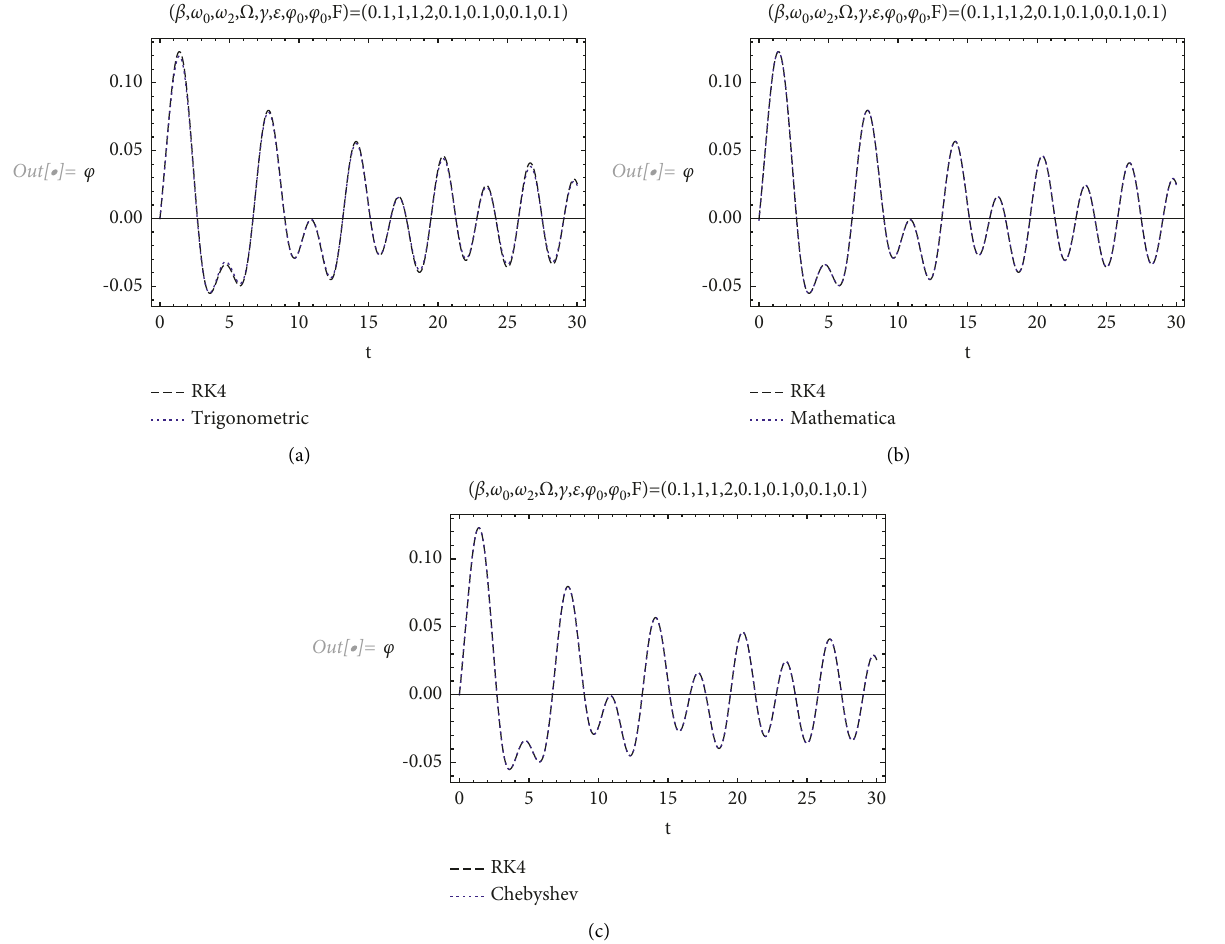
Figure 6: The comparison between the analytical approximation (16) and the numerical approximations using the Chebyshev collocation method and RK numerical method as well as the MATHEMATICA command Fit to i.v.p. (3) for case (4):